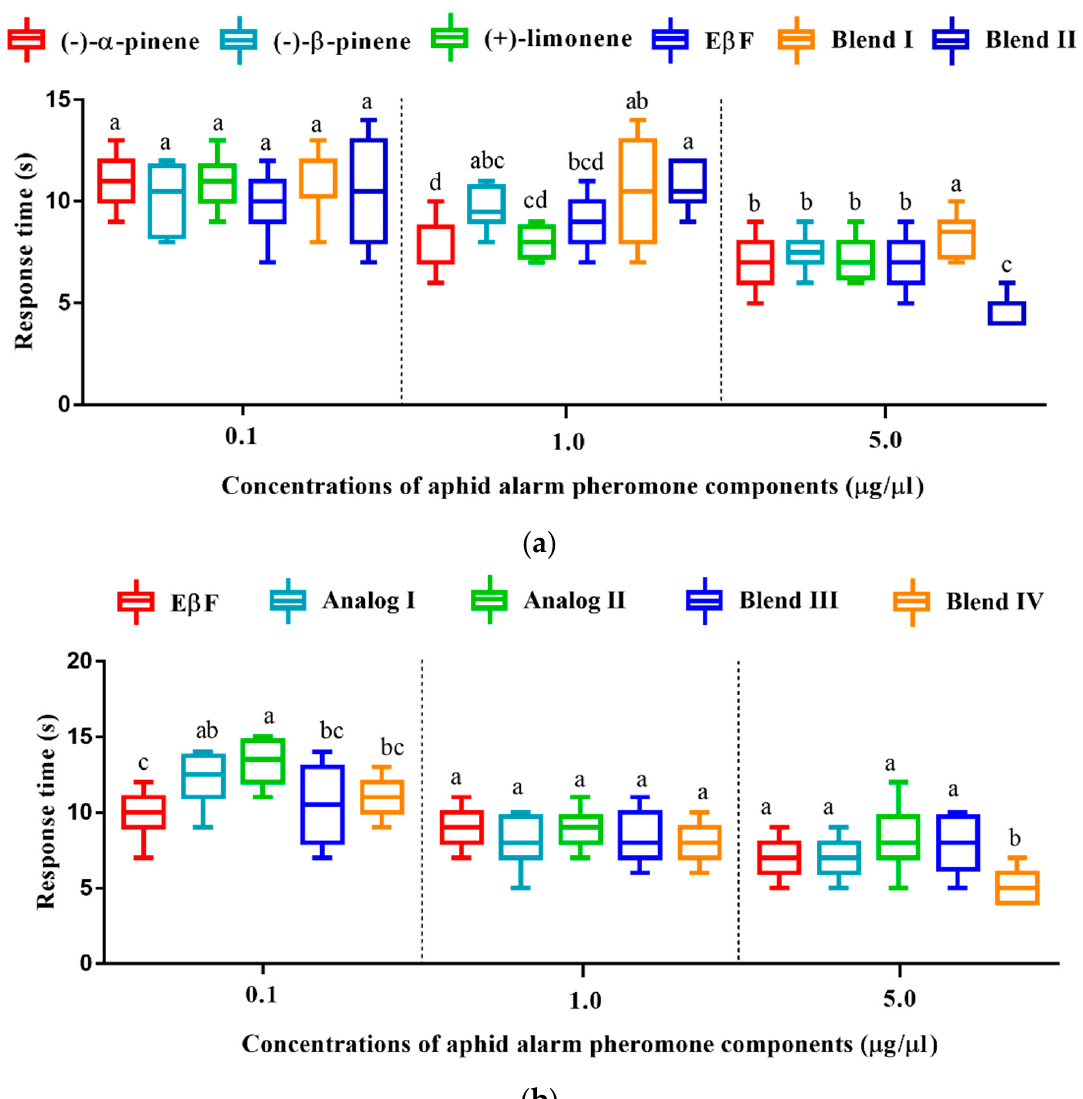
Figure 4. Mean (± SE) time, in seconds, for Diaeretiella rapae to choose single or blends of pheromone and analogs in a T-tube olfactometer. (a) Response time of D. rapae to single and blend components of aphid alarm pheromone. (b) Response time of D. rapae to single and blend compounds of E β F and its analogs. The significant differences in the response time of the compounds were analyzed statistically using one-way analysis of variance (ANOVA), followed by Tukey’s B test at p < 0.05. Different letters indicate significant differences.